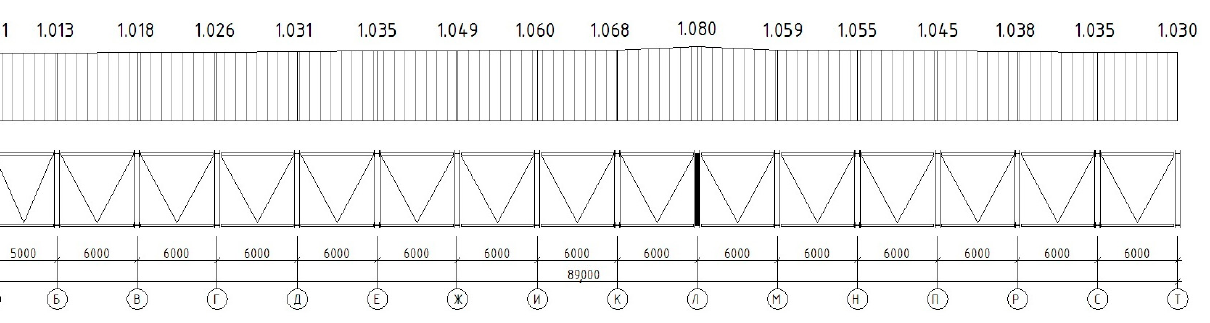
Figure 25. Long-span truss in a spatial frame with additional vertical bracing.